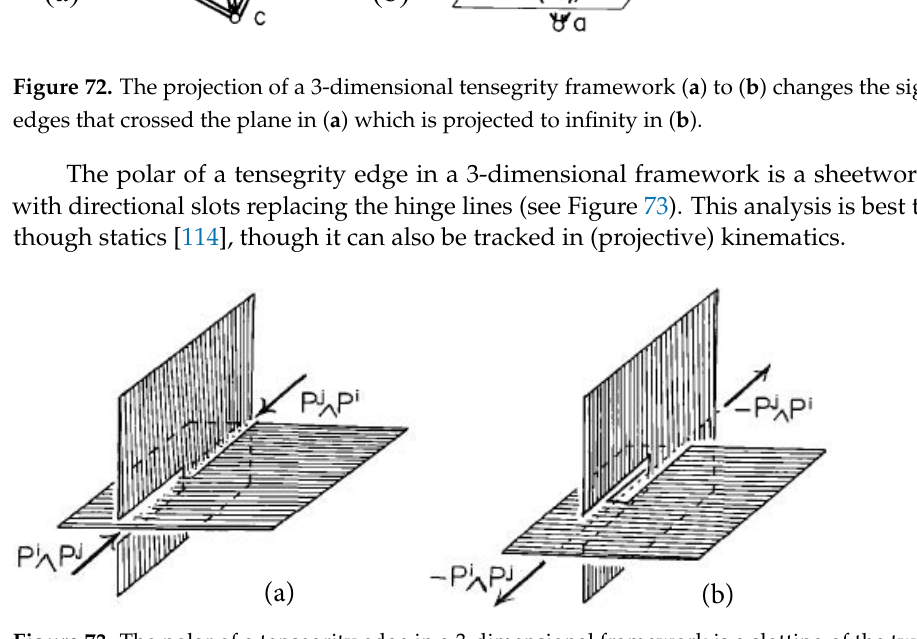
Figure 73. The polar of a tensegrity edge in a 3-dimensional framework is a slotting of the two sheets which blocks one direction of forces along the hinge ( a ) but permits motions sliding in the other direction along the hinge, as well as rotations around the hinge line ( b